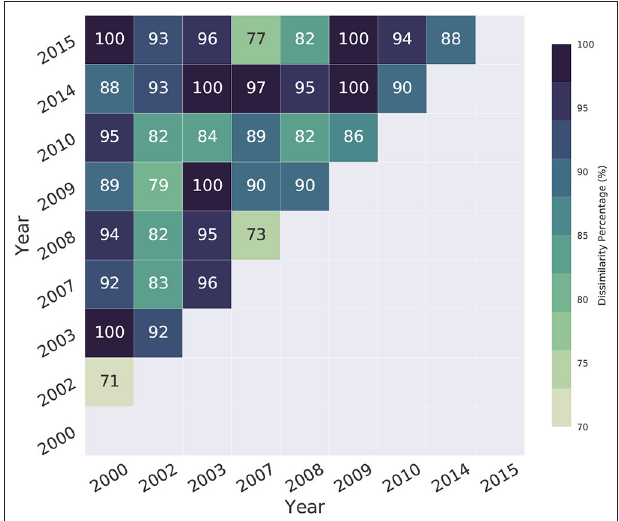
FIGURE 9 | Dissimilarity percentage between pairs of events. This shows the percentage of reef connections between events whose i-j position in the connectivity matrices